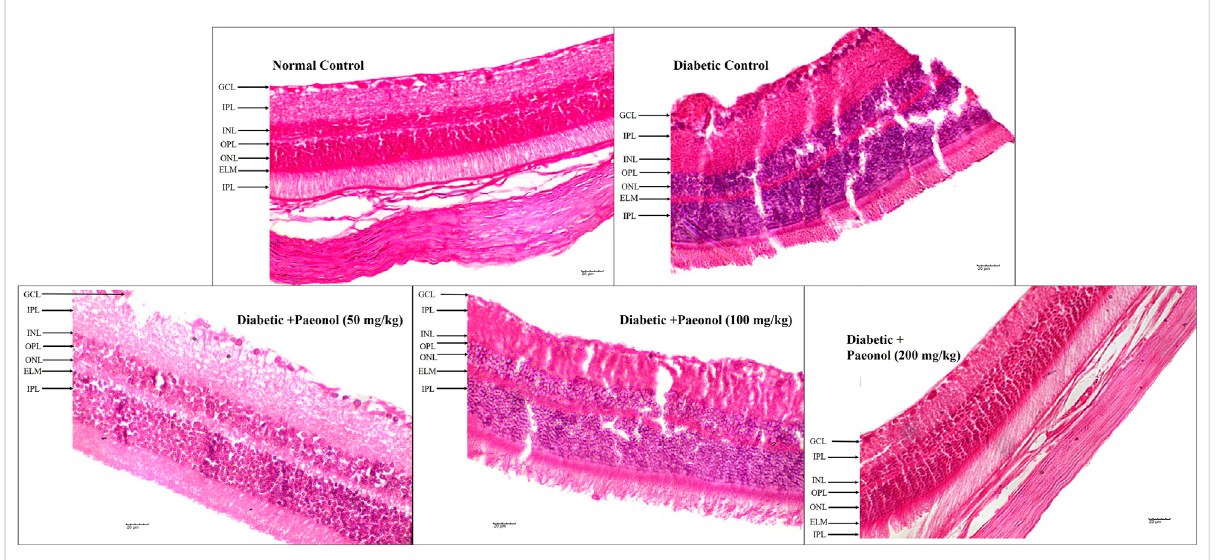
FIGURE 2 Effect of paeonol on the histopathology of the eye in the experimental animals (400 X) (GCL, ganglion cell layer; IPL, inner plexiform layer; INL, inner nuclear layer; OPL, outer plexiform layer; ONL, outer nuclear layer, ELM, external limiting